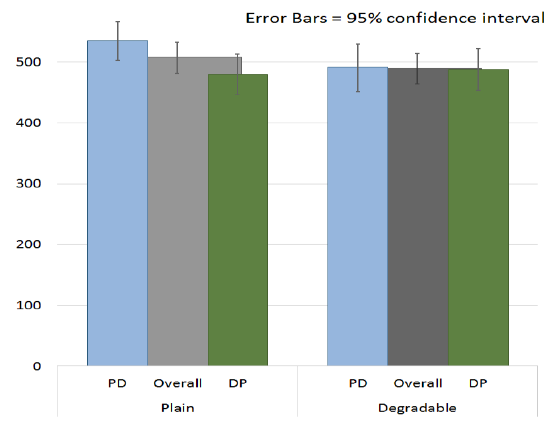
Figure 5: Total time for study (phase 3) walks